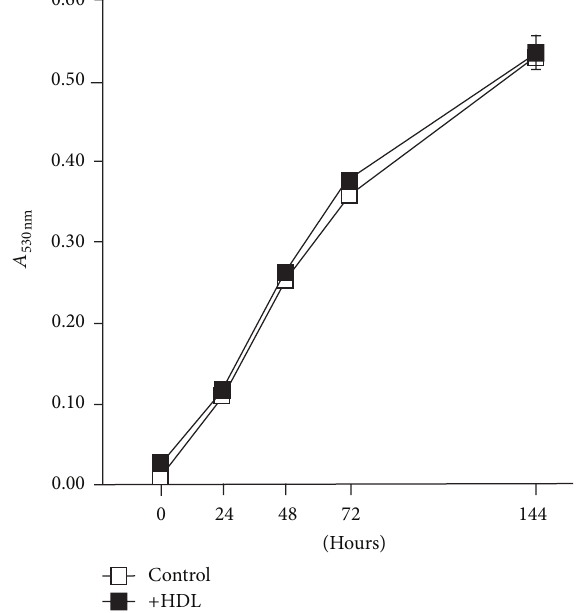
Figure 3: Bactericidal activity of HDL. M. avium was cultured with (+HDL; 50 𝜇 g protein/mL) or without (control) HDL and absorbance (at 530 nm) of the medium was measured at 0, 24, 48, 72, and 144h. The values were indicated by mean ± SEM ( 𝑛 = 3 ).